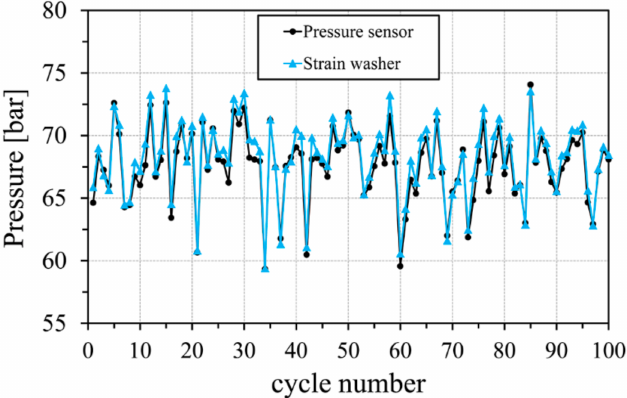
Figure 11. Maximum in-cylinder pressure evaluated by the pressure sensor and the strain washer at 4500 rpm and full throttle on 100 consecutive cycles.